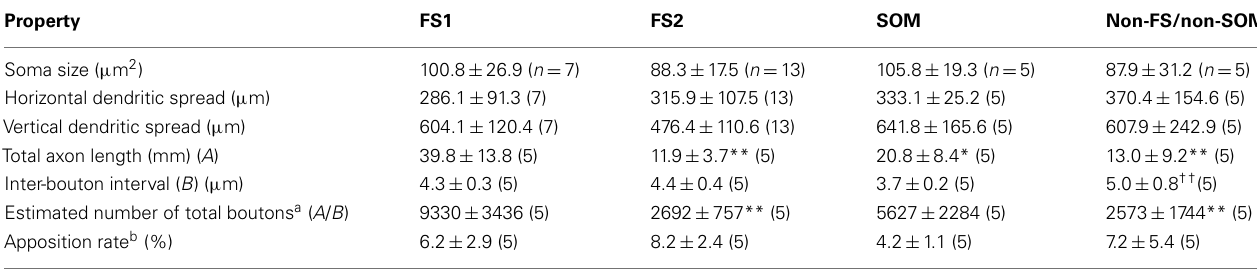
Table 4 | Morphological properties of FS1, FS2, SOM, and Non-FS/non-SOM neurons.